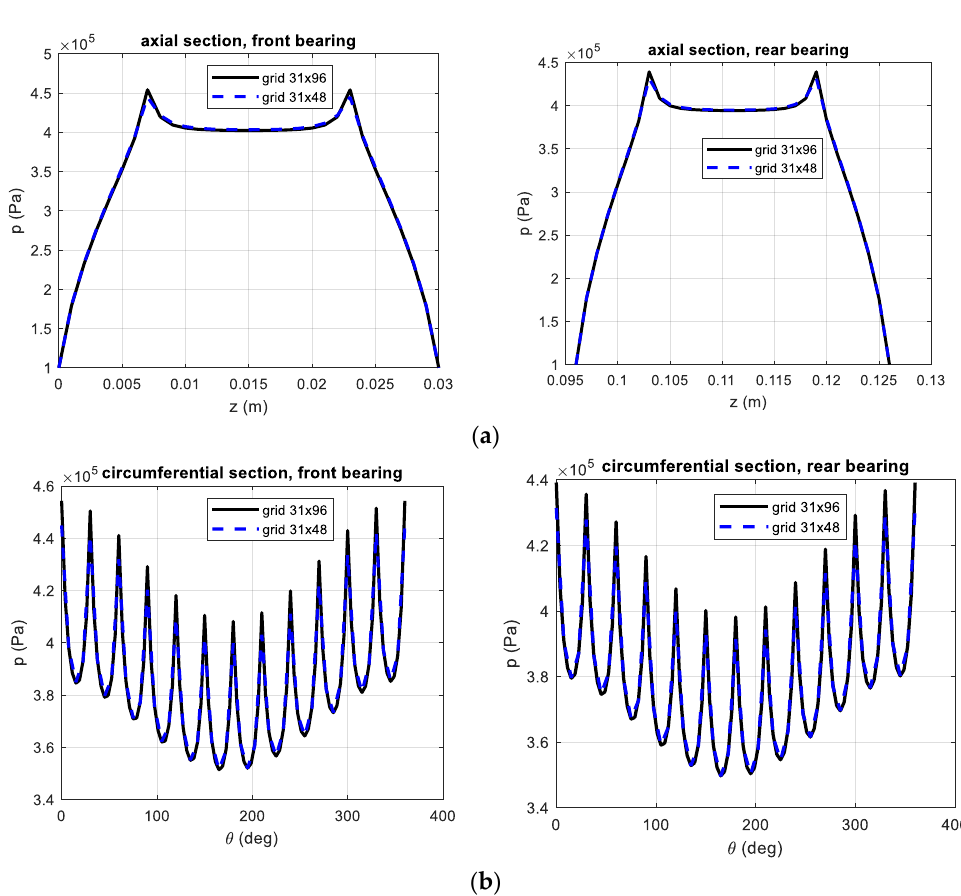
Figure 8. Axial ( a ) and circumferential ( b ) pressure distributions obtained with different numbers of grid points along the circumferential direction (48 and 96); 𝑝 𝑠 = 0.5 MPa.